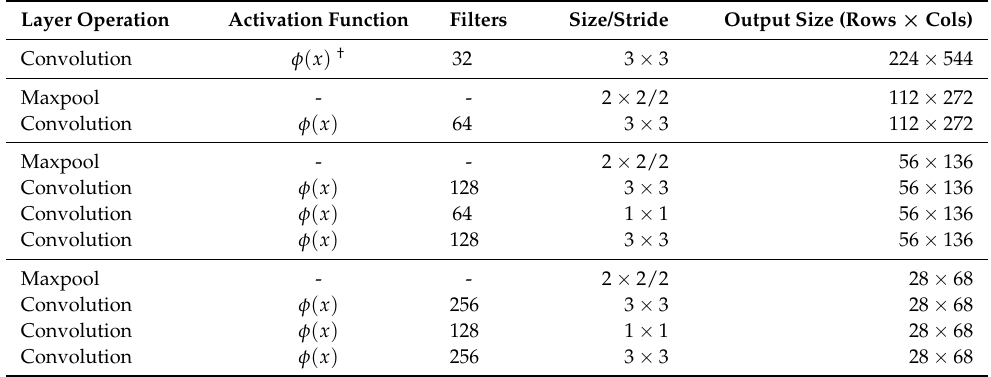
Table 1. Layer descriptions of the convolutional neural network for tree stem detection.